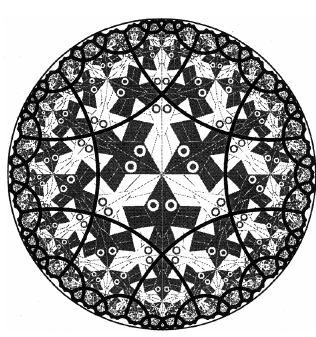
Figure 4: Repeating the main pattern on a hyperbolic plane